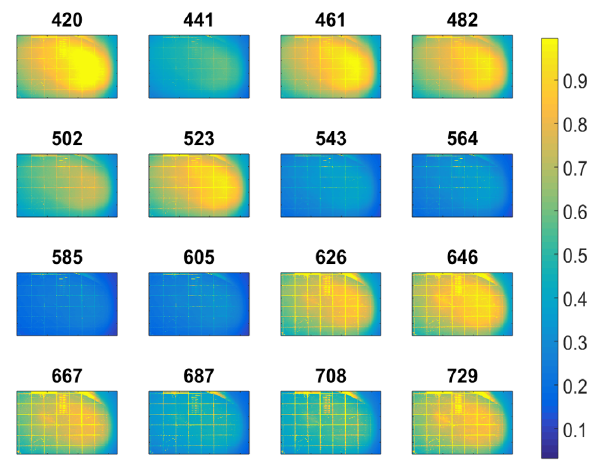
Figure 4. Surface reflection images at different wavelengths (16 filter settings) in the polysilicon (PS) device. Numbers indicate the central wavelength transmitted and the side colorbar denotes the relative intensity R normalized to